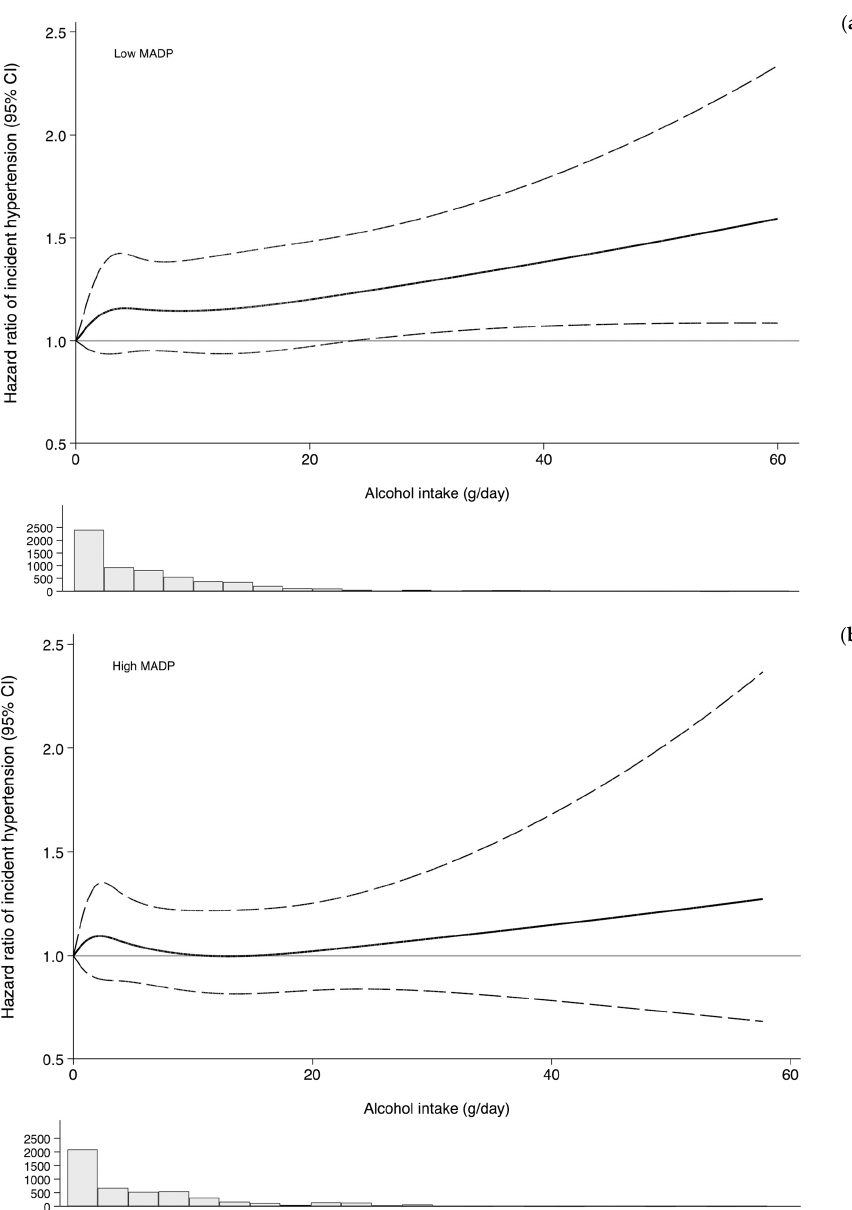
Figure 3. Hazard ratios (solid line) and 95% confidence interval (dashed lines) of incidence hyper- tension according to alcohol intake. Dose-response relationship, stratified by Mediterranean alcohol drinking pattern adherence (( a ) low MADP = 0–3; ( b ) high MADP = 4–7) using restricted cubic splines. The histogram below the graph represents the distribution of participants by alcohol intake levels. The SUN Project 1999–2018. Adjusted for age, sex, body mass index (Kg/m 2 , quintiles), smoking habit (never, former intensive, former non-intensive, current smoker intensive, current smoker non-intensive), leisure-time physical activity (MET-h/week), total energy intake (Kcal/d, quintiles), adherence to the Mediterranean dietary pattern (tertiles), time spent watching televi- sion (h/d, continuous), sugar-sweetened beverages intake (tertiles), aspirin or NSAID treatment, fried-food consumption (tertiles), fast-food consumption (tertiles), and energy-adjusted sodium intake